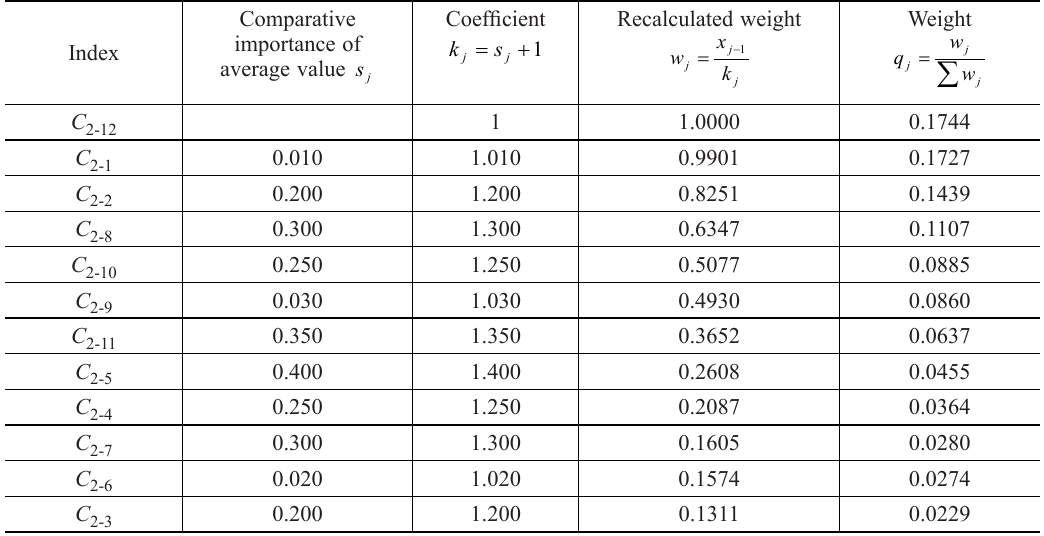
Table 6. Priorities and final weights of sub-indexes reflecting relationship among spaces in crisis